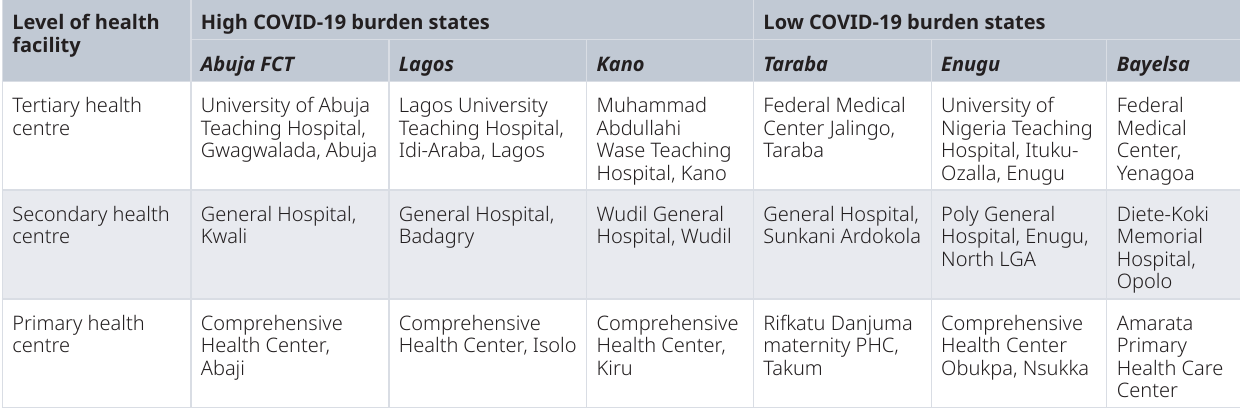
Table 1. List of participating states and health